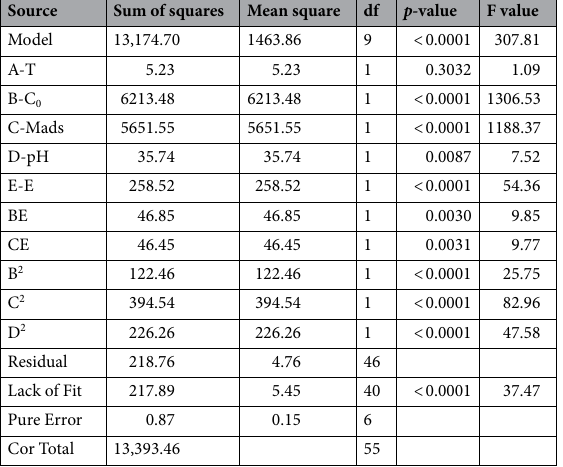
Table 2. Analysis of variance for the response surface reduced quadratic model for strontium biosorption.